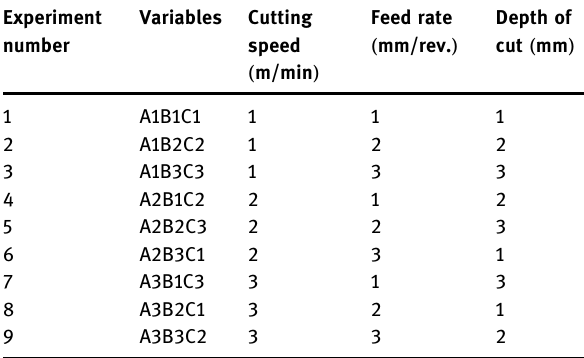
Table 3: Experimental design